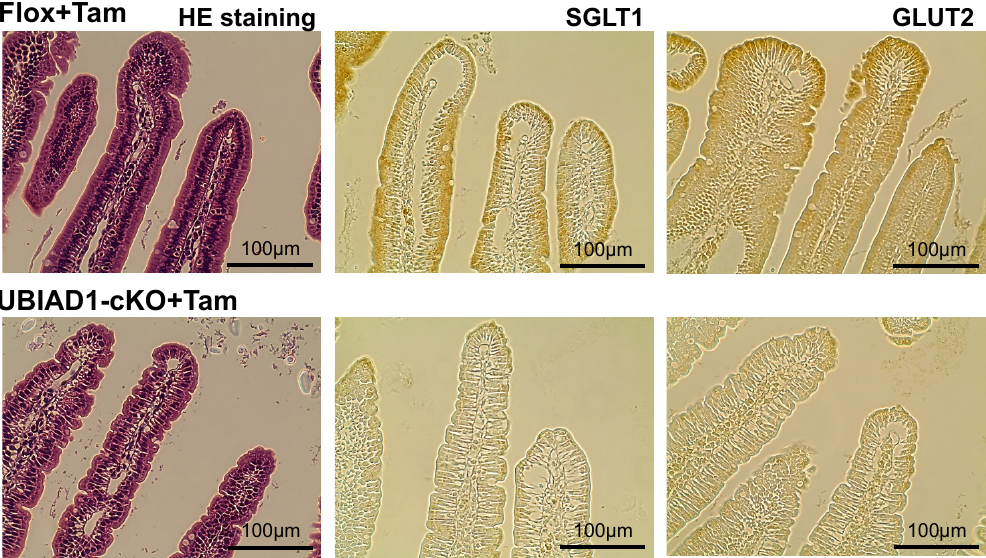
Figure 9. H&E-stained and immunohistologically stained duodenum sections from female Flox and UBIAD1-cKO mice at 40 days after administration of tamoxifen. Immunohistological staining demonstrated sodium-dependent glucose transporter 1 (SGLT1) and glucose transporter 2 (GLUT2) expressions in the duodenum of the mice at 40 days after tamoxifen administration